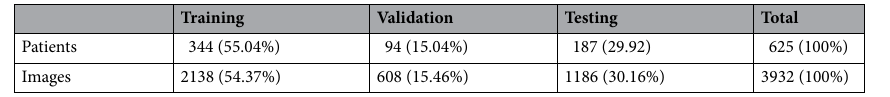
Table 1. Numbers of patients and images assigned to training, validation, and testing subsets.